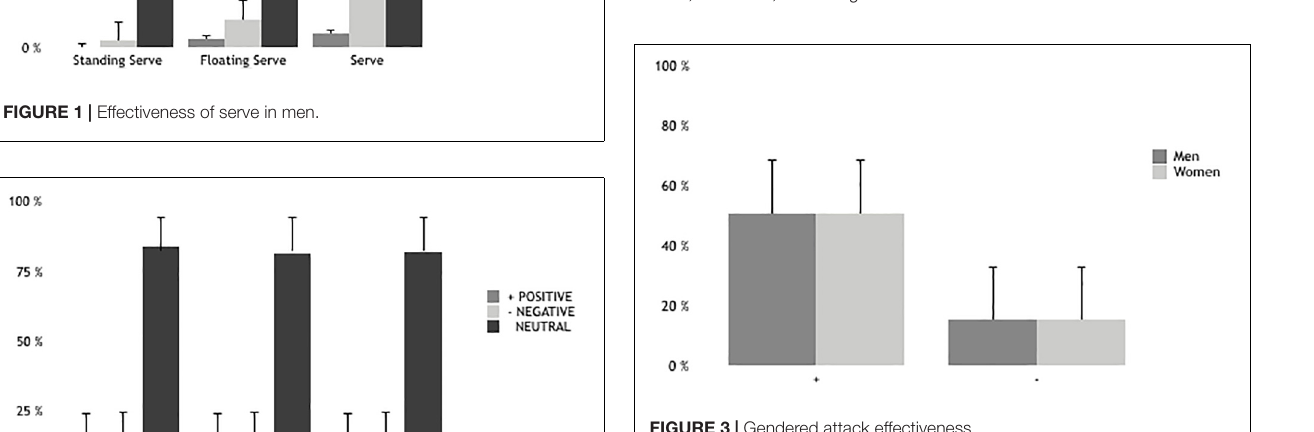
FIGURE 3 | Gendered attack